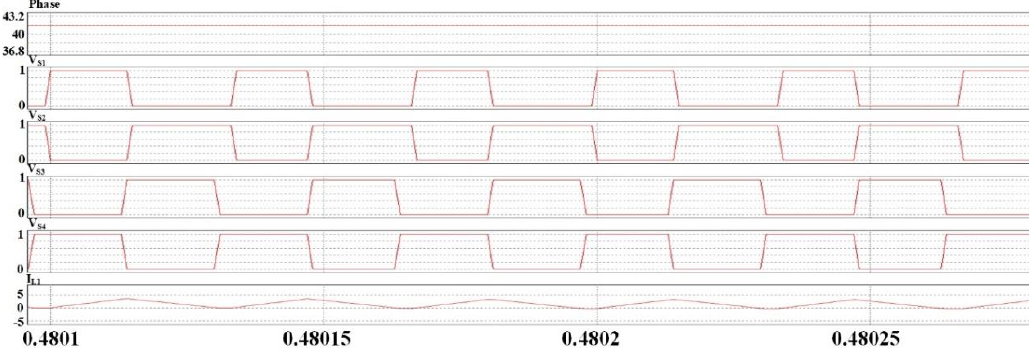
Figure 12. Simulated gating signals and inductor current under buck-charging mode (load = 300 W).